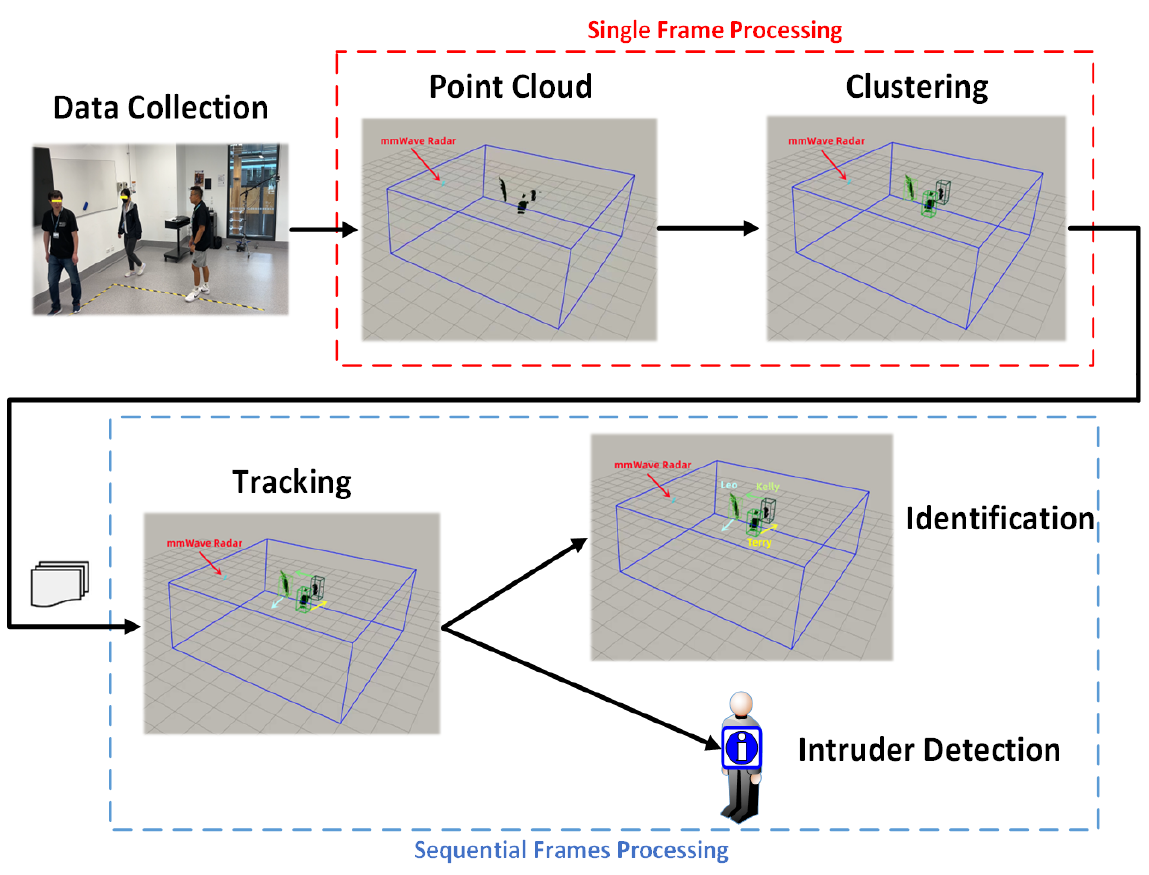
Figure 1. System